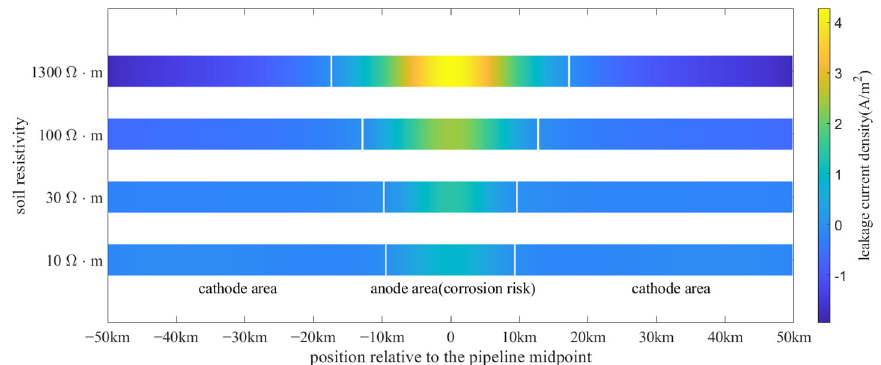
Figure 16. Corrosion risk area distribution under different soil resistivity.